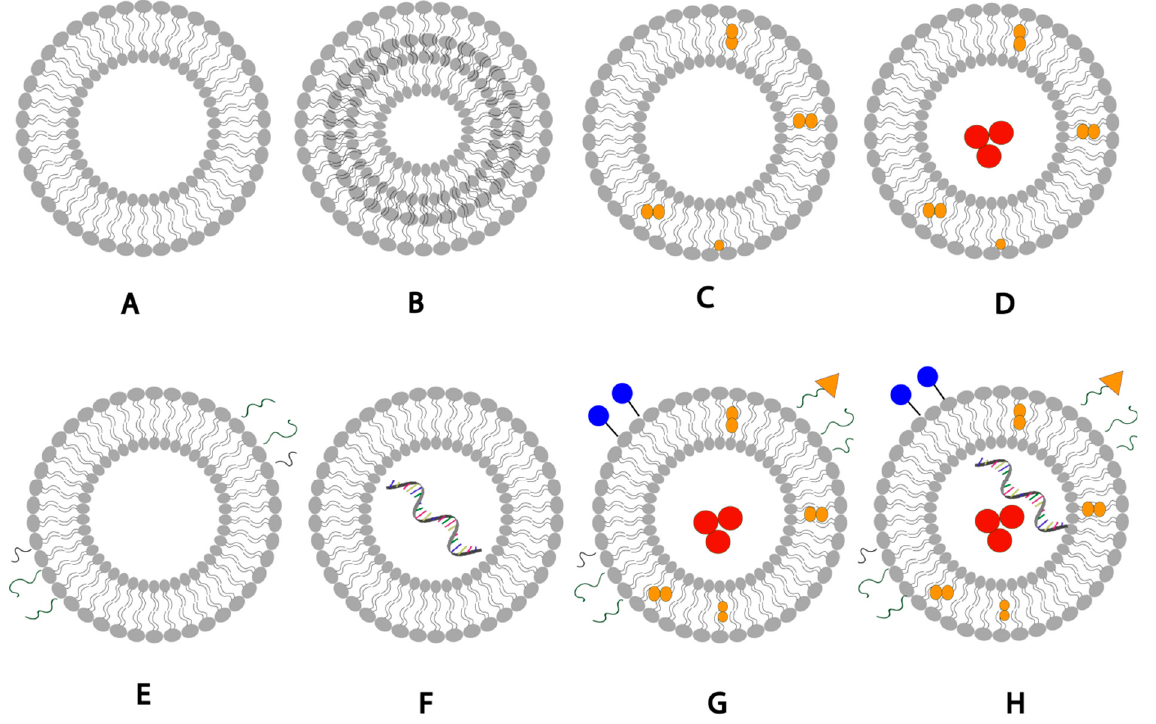
Figure 2. Schematic representation of liposomal drug delivery systems: ( A ) unilamellar liposome, ( B ) multilamellar liposome, ( C ) liposome loaded with a hydrophobic drug, ( D ) liposome loaded with a hydrophobic drug in the bi- layer membrane and a hydrophilic drug in the aqueous core, ( E ) pegylated liposome with surface PEG polymer chains, ( F ) liposome loaded with mRNA, ( G ) liposome with a surface-conjugated drug, targeting ligands and PEG, hydrophilic and hydrophobic drugs, ( H ) liposome with a surface-conjugated drug, targeting ligands, PEG polymer chains, hydrophilic drugs, hydrophobic drugs,